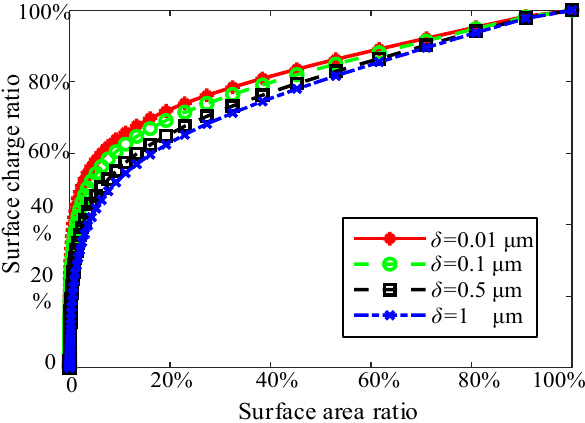
Figure 9. Surface charge ratio as a function of surface area ratio for different probing gaps.